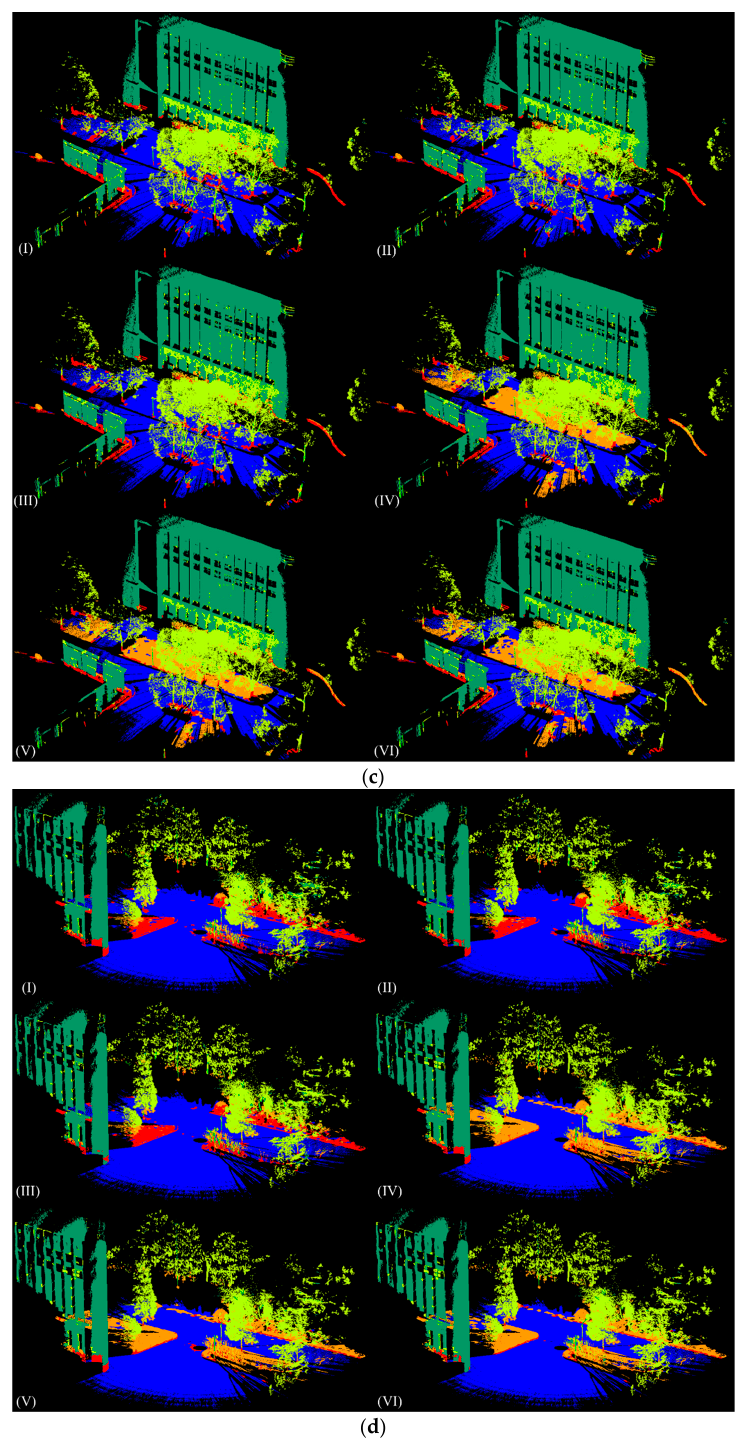
Figure 4. Visualization of the classification results of four testing sets: ( a ) testing set 1, ( b ) testing set 2, ( c ) testing set 3, and ( d ) testing set 4, obtained through six feature sets: (I) Geo, (II) Geo & OI, (III) Geo & CI, (IV) Geo & C, (V) Geo & C & OI, (VI) Geo & C & CI. Legend for labels: ground façade pole tree vegetation